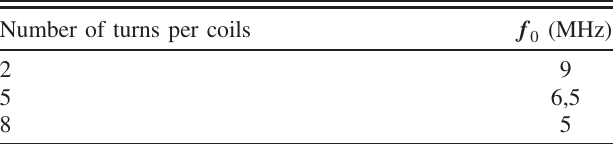
TABLE II. Resonating frequencies of rf voltages with various numbers of turns per